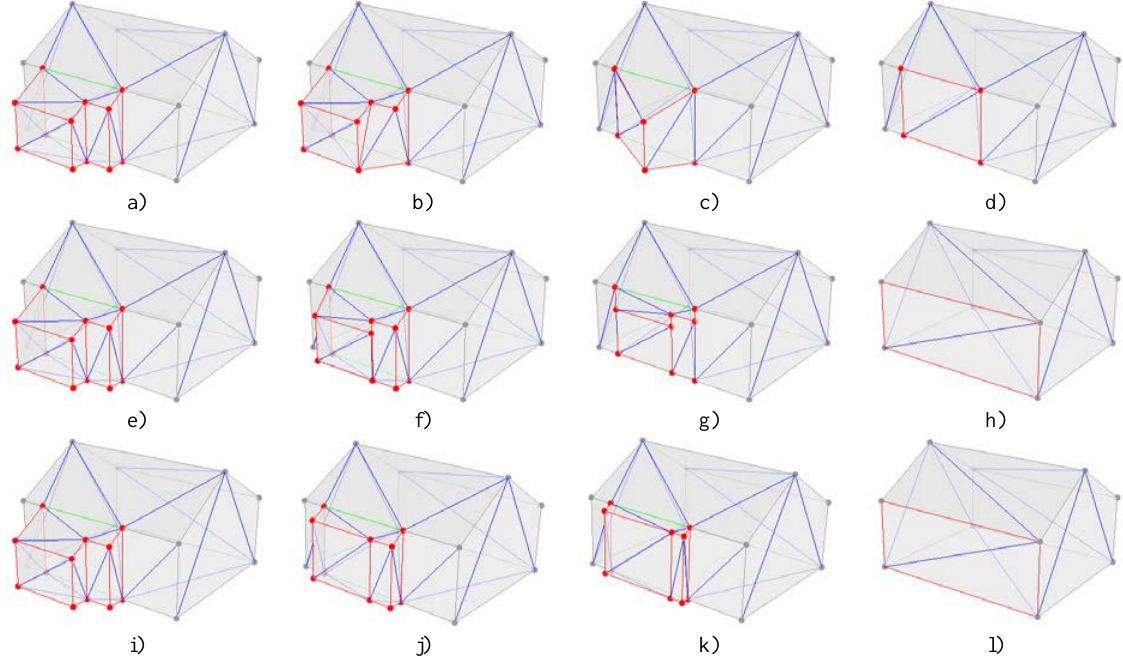
Figure 3. Comparison of the three transformation strategies between different LODs: Shortest Edge First a)-d), Push Plane e)-h), and Sweep Plane i)-l) (red – nodes and edges which have to be eliminated, green – joint edges, blue – temporary TIN).